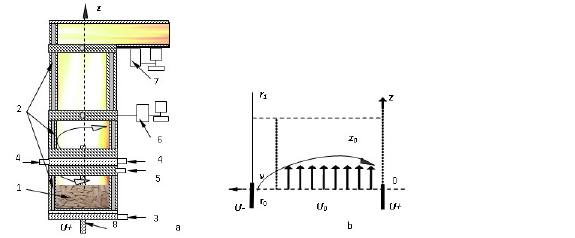
Figure 2. a: the pilot device for experimental studies - 1. biomass gasifier; 2. water-cooled sections of the combustor; 3. primary axial air supply; 4. secondary swirling air supply; 5. propane flame supply; 6., 7. orifices for diagnostic tools; 8. positively biased electrode, b: principal computational